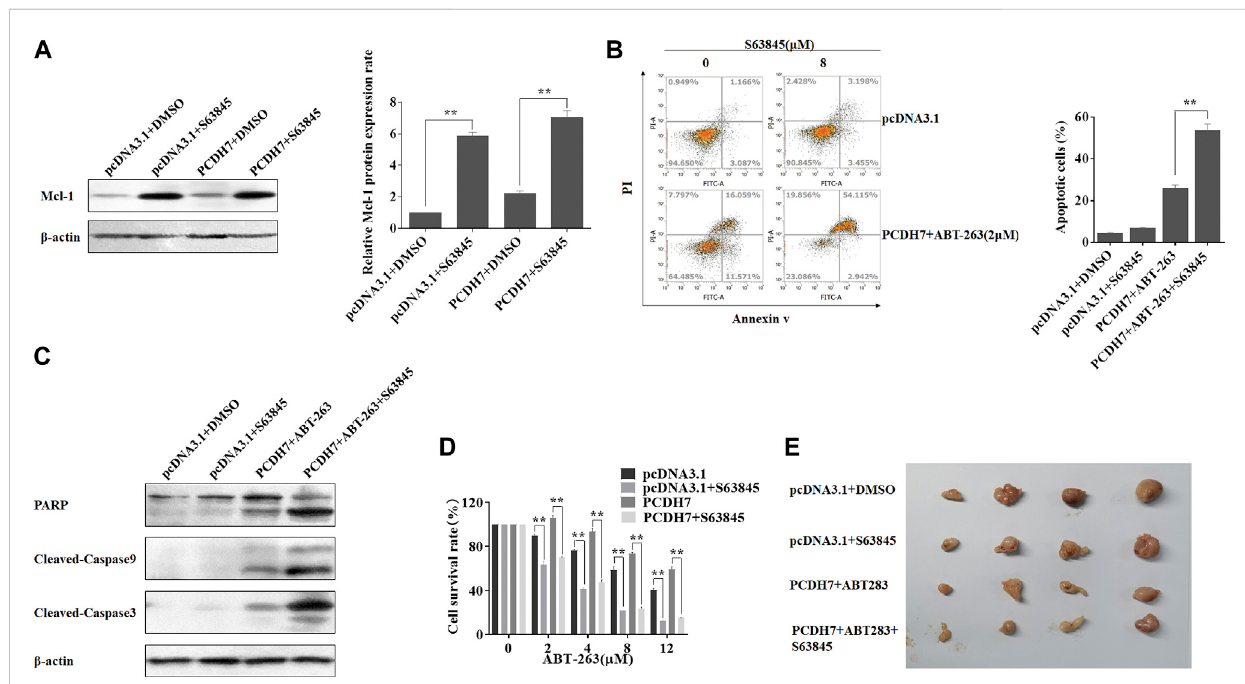
FIGURE 8 PCDH7 mediated the drug resistance of CRC via upregulating Mcl-1. (A) HCT116 cells were transfected with the PCDH7-overexpressed plasmid or treated with 8 μ M S63845 for 24 h, and Mcl-1 protein expression was examined by Western blot assay. (B) HCT116 cells were transfected with the PCDH7 overexpressed plasmid combined with 2 μ M ABT-263 with or without the treatment of 8 μ M S63845 for 24 h. Cell apoptosis was determined using fl ow cytometry with Annexin V-FITC/PI staining. (C) Cleavage of PARP, caspase-3, and caspase-9 in HCT116 cells treated similarly in (B) was examined by Western blot assay. (D) HCT116 cells were transfected with the PCDH7 overexpressed plasmid with or without S63845 treatment, followed bytheincubationof theindicatedconcentrations ofABT-263; MTT assay wasperformed to determine thecell viability. (E) HCT116cells stably expressed PCDH7,orthecontrolcellswereusedtogeneratexenograftsinnudemice.Themiceweretreatedasindicated,andthetumorswerepresented.Dataare presented as mean ± SD for three separate experiments. ** p < 0.01 vs.